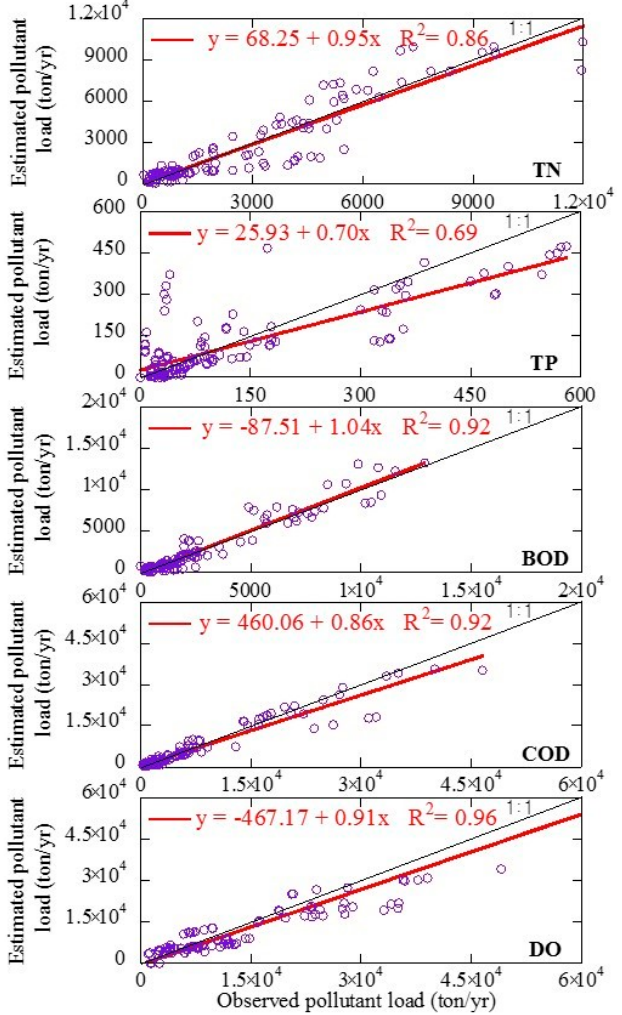
Figure 4. Comparison of observed and predicted water pollution loads in 30 river basins in Japan for the 5 year validation period (2000–2004). The 1:1 line is plotted for comparison.